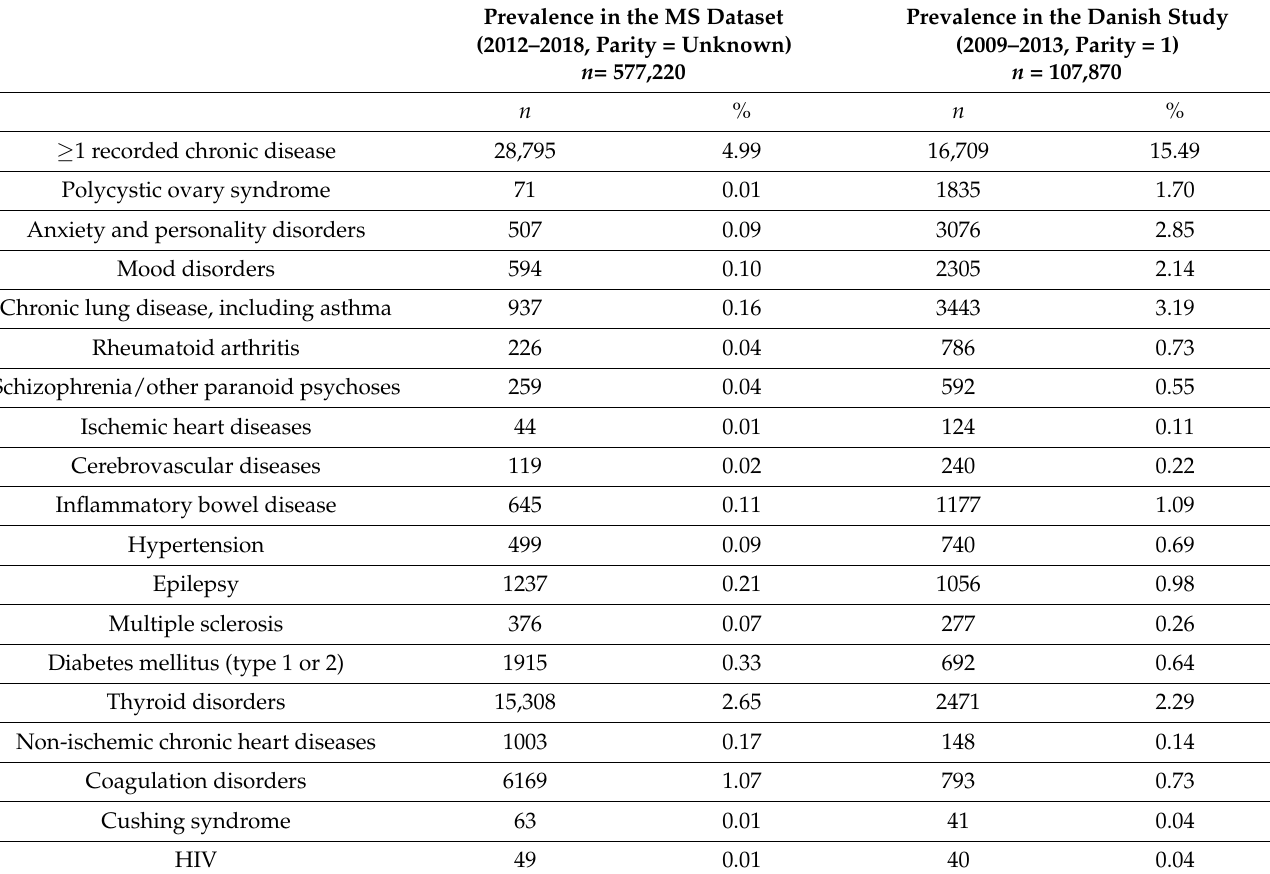
Table 2. Prevalence of recorded chronic diseases in the MS dataset compared to the Danish study sorted by descending relative difference (relative difference = prevalence Danish study /prevalence MS dataset